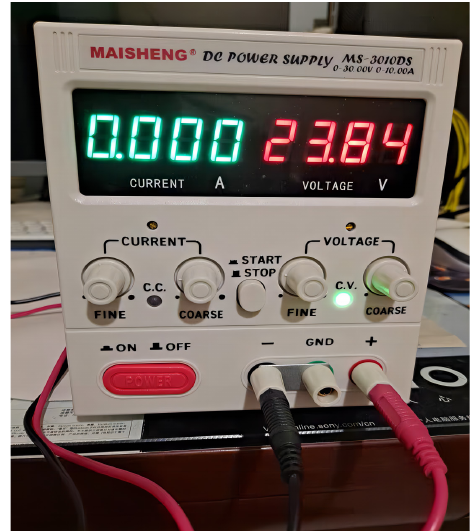
Figure 17. M S DC Power Supply.